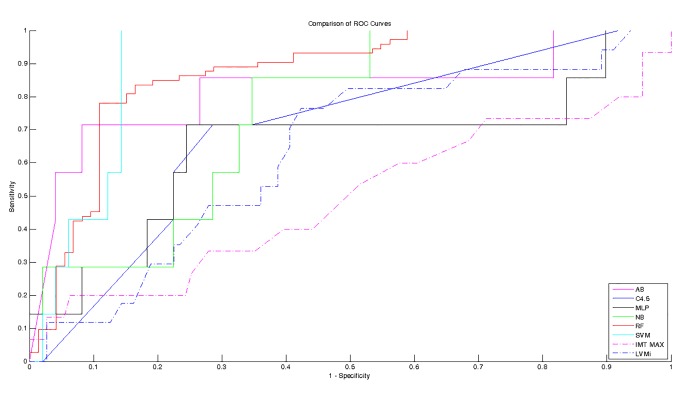
Receiver-operator characteristic curves for predicting vascular events by HRV-based classifiers and echographic parameters.The HRV-based classifiers are able to predict vascular events with higher sensitivity and specificity rate than echographic parameters. Sensitivity is determined from the proportion of patient developing a vascular event identified as high risk; specificity is determined from the proportion of patient free of vascular events identified as low risk. Solid lines represent classifier based on HRV features, dash-dot lines represent classifications based on echographic parameters. AB: Adaboost. MLP: Multilayer Perceptron. NB: Naïve Bayes classifier. RF: Random Forest. SVM: Support Vector Machine. LVMi.: Left ventricular mass index. IMT MAX: maximum of intima media thickness.